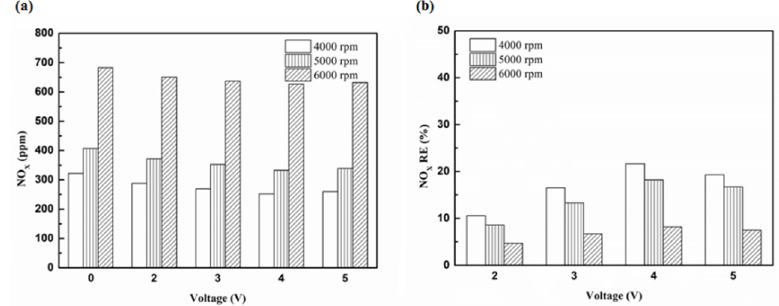
Figure 29. The NO x ( a ) emission values and ( b ) RE using iridium alloy in the front of the exhaust pipe.